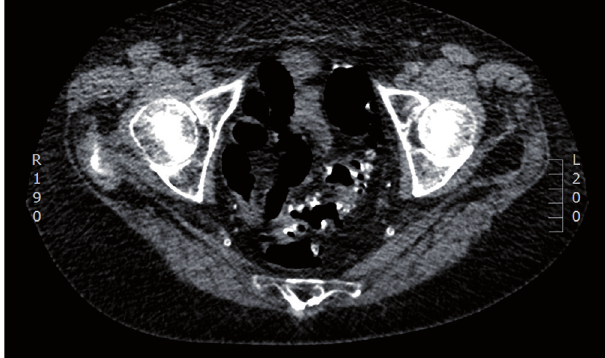
Figure 3. CT colonography depicting extensive diverticular disease and narrowing of the distal